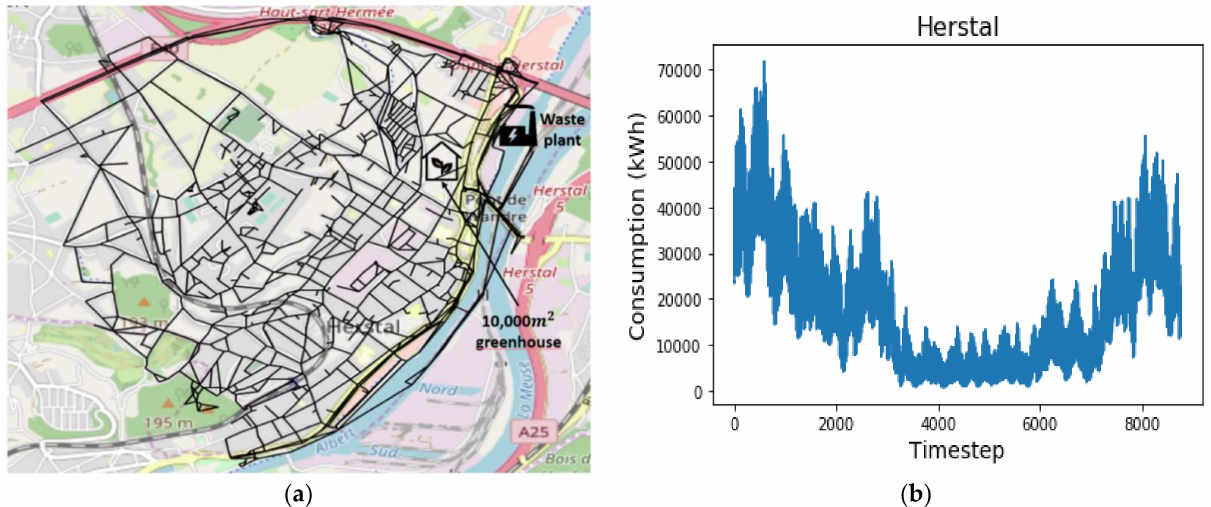
Figure 1. ( a ) Large-scale case-study with nearly 2000 streets. ( b ) Total heating demand of this case